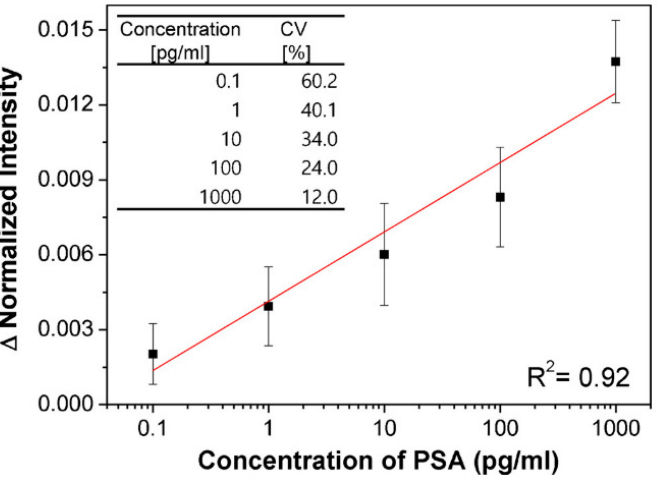
Figure 36. Limit detection of PSA. Reprinted with permission of [98].